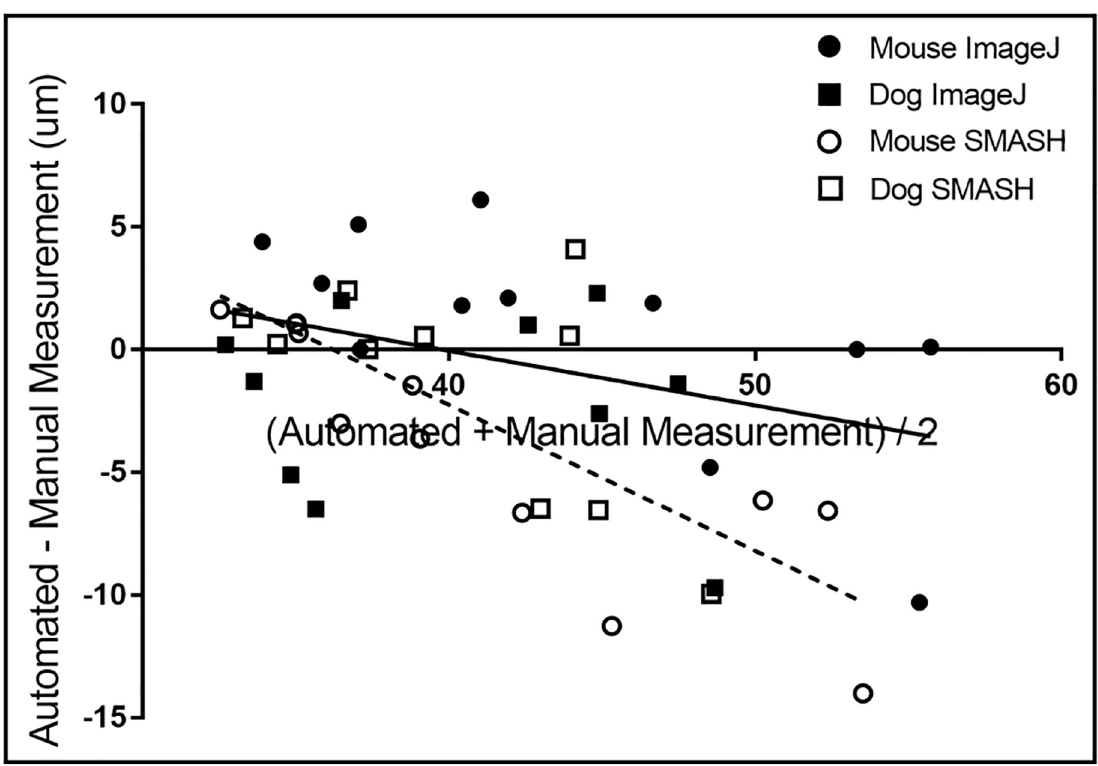
Fig 3. Combined Bland-Altman plot for murine and canine fiber diameter data obtained using MyoSAT, and SMASH compared to manual tracing method (Ground truth). Linear regression: MyoSAT: y = -0.22x + 8.8. SMASH: y = -0.58x +21.